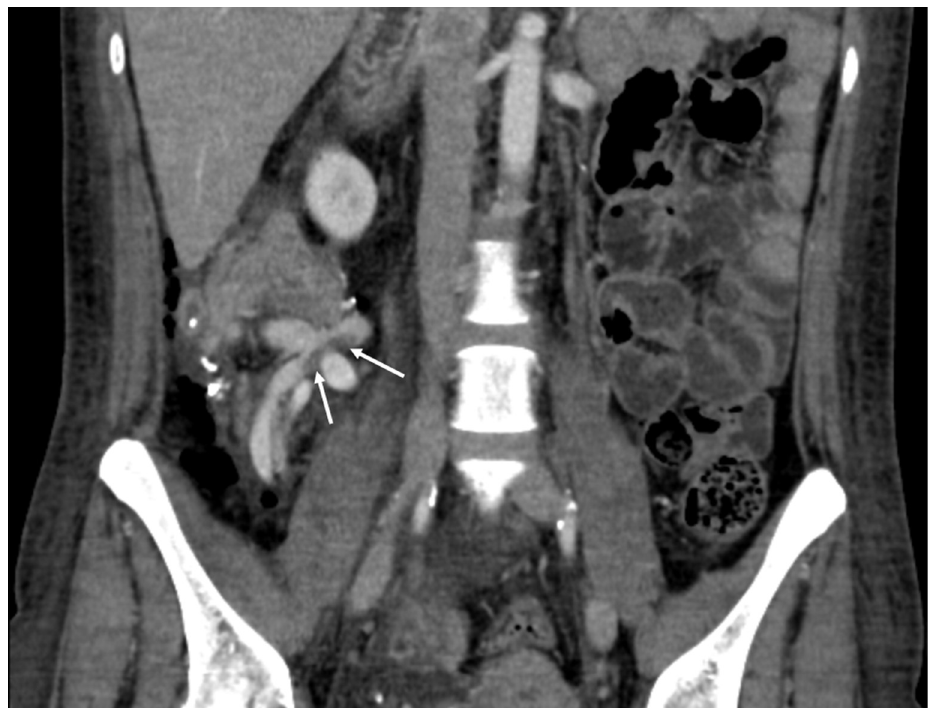
Fig 4. Thrombus on CT scan. Computed tomography scans with intravenous contrast in venous phase of a pancreas transplanted patient showing a thrombus in the portal segment of the graft vein.